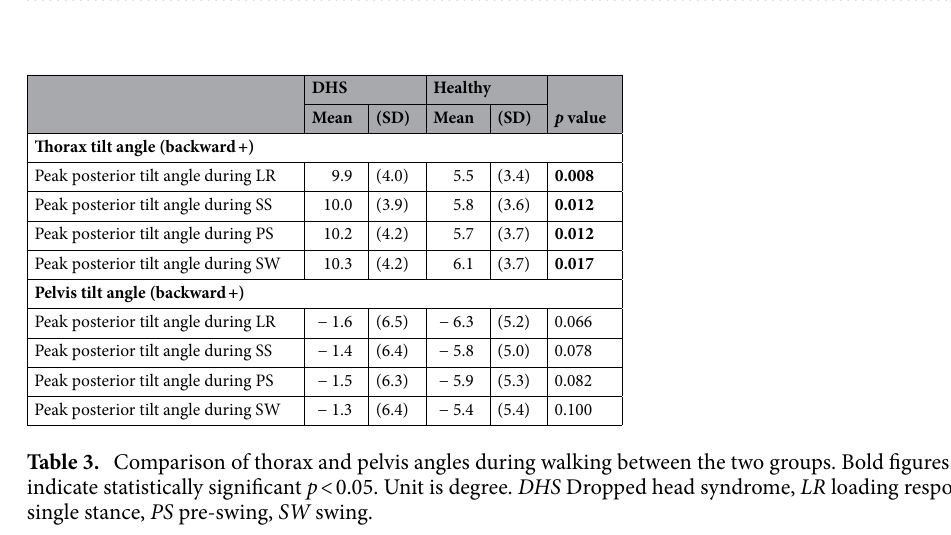
Table 2. Comparison of spatiotemporal parameters between the two groups. Bold figures indicate statistically significant p < 0.05. DHS Dropped head syndrome.